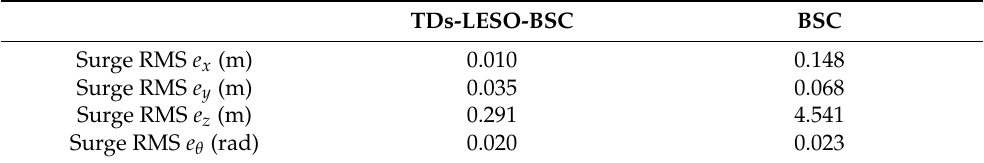
Figure 18. The contrasts of the state tracking errors in the raster scan trajectory tracking case. Table 4. The RMS errors of the TASR in the raster scan trajectory